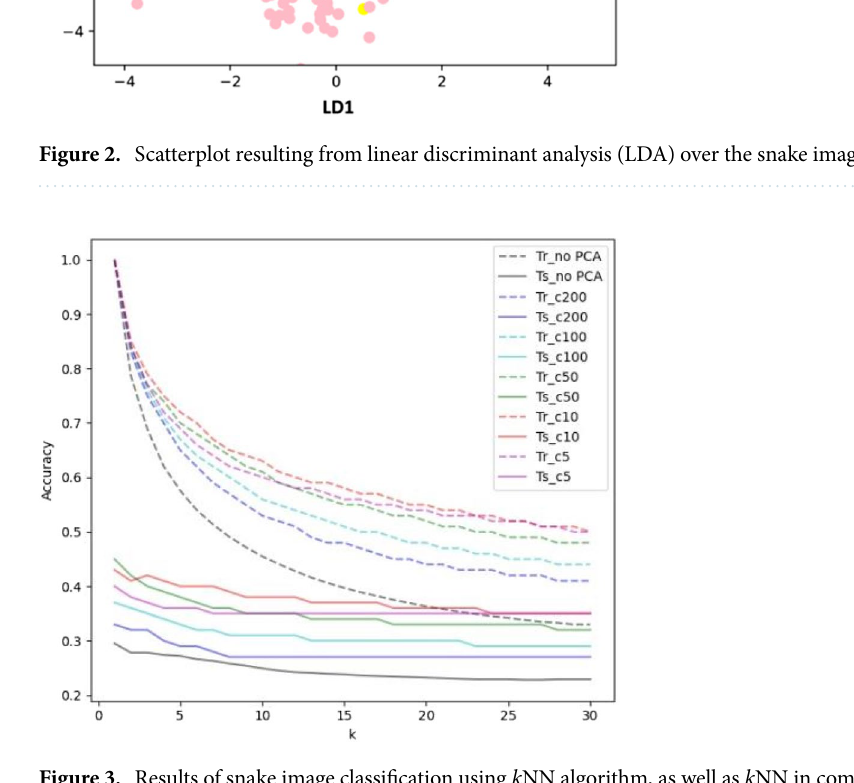
Figure 3. Results of snake image classification using k NN algorithm, as well as k NN in combination with a data dimension reduction approach (PCA), while k has been changing in a range from 1 to 30. The number of the components (c) is 5, 10, 50, 100 and